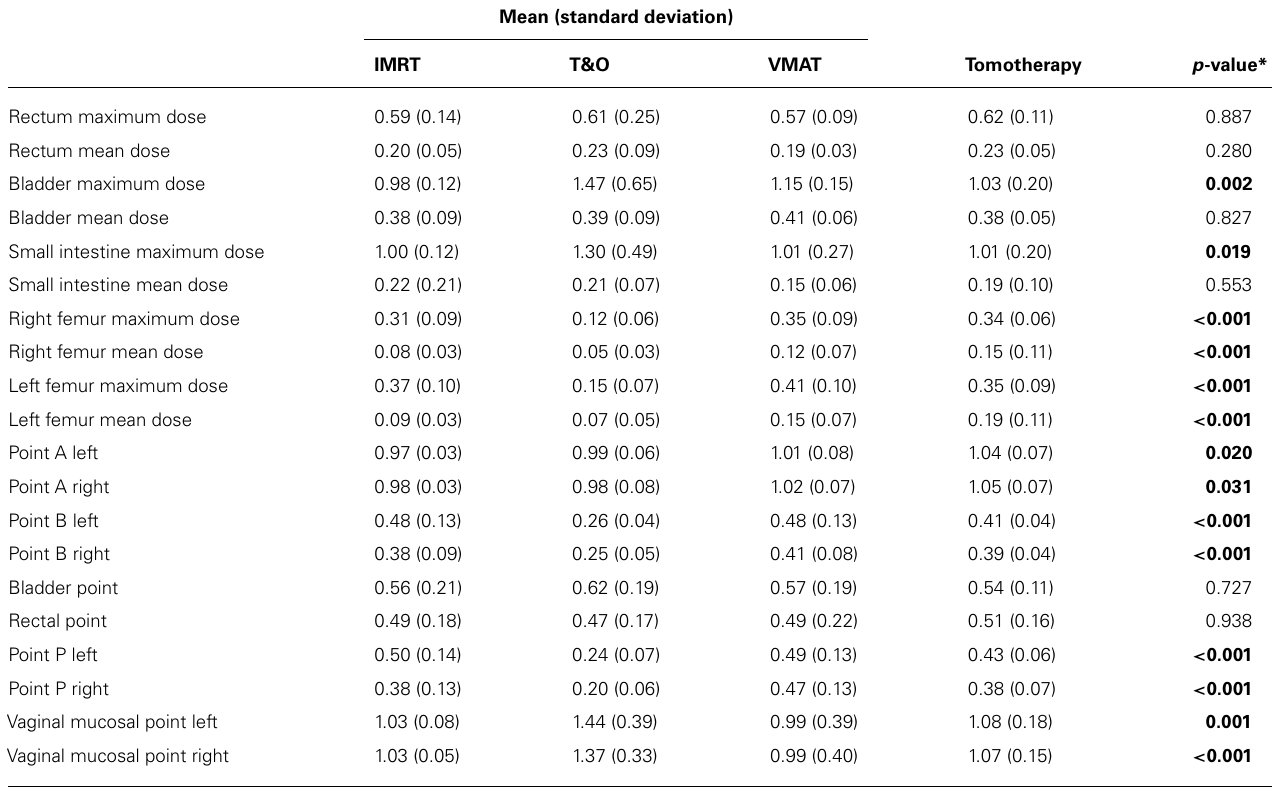
*Single-factor ANOVA. IMRT, intensity-modulated radiotherapy;T&O, tandem and ovoid;VMAT, volumetric arc radiotherapy. Statistically significant ANOVA values are represented in